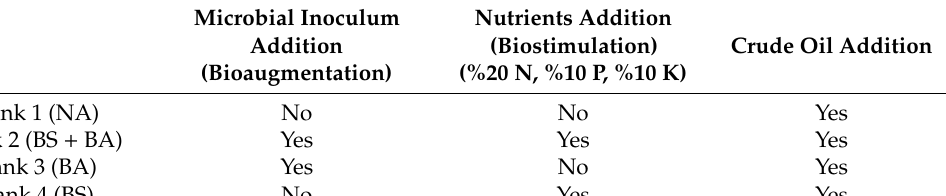
Table 1. Configuration of the treatment tanks.